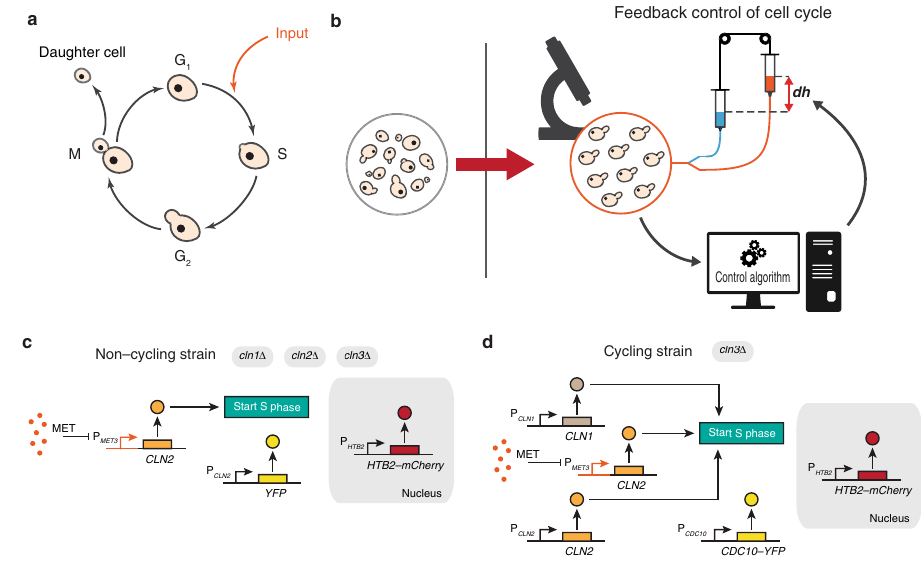
Fig. 1 Synchronisation of cell cycle in yeast S. cerevisiae through automatic feedback control. a Schematic representation of the cell cycle in yeast Saccharomyces cerevisiae . Yeast strains were engineered to initiate the cell cycle upon methionine depletion from the growth medium (input). b Yeast cells do not cycle synchronously in a population. Schematics of the computer-controlled micro fl uidics platform to automatically synchronise the cell cycle across a population of yeast cells. c Non-cycling yeast strain. Cells are deleted for genes encoding for the G 1 cyclins Cln1-3 while an exogeneous G 1 cyclin gene CLN2 is placed under the control of the methionine-repressible promoter P MET3 . Cells can cycle only in the absence of methionine. A yellow fl uorescent protein (YFP) is expressed under the control of the endogenous promoter P CLN2 . A red fl uorescent nuclear reporter, consisting of a fusion protein between the endogenous histone H2B protein and the mCherry (Htb2-mCherry) is also present in this strain. d Cycling yeast strain. Cells are deleted only for the G 1 cyclin Cln3, hence cells continuously cycle. An exogeneous copy of the G 1 cyclin gene CLN2 is placed under the control of the methionine-repressible promoter P MET3 . A red nuclear fl uorescence reporter (Htb2-mCherry) and a yellow fl uorescence reporter, consisting of a fusion protein between endogenous mitotic septin Cdc10 and YFP (Cdc10-YFP), are also present in this